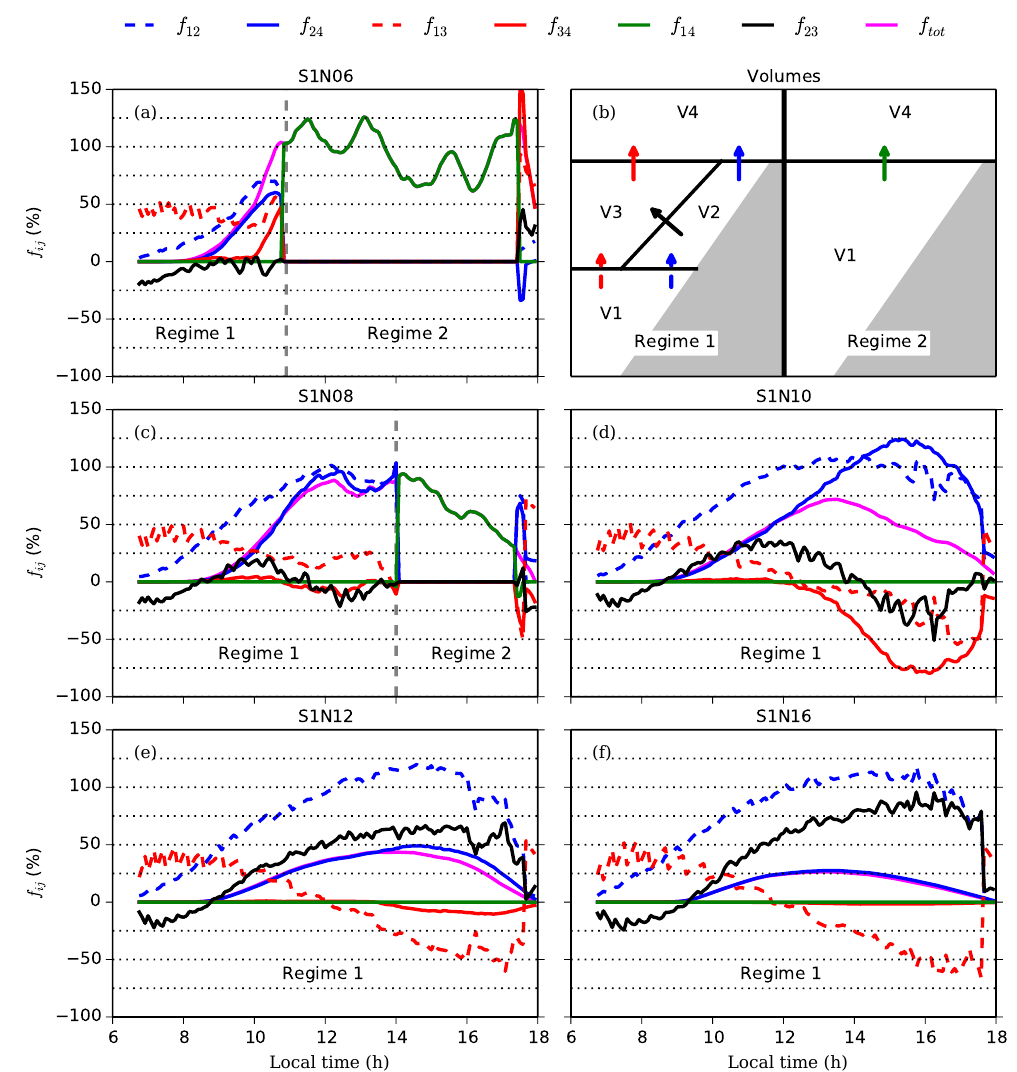
Figure 4. Normalized bulk tracer mass flux for a set of S1 simulations with five different values of initial static stability: (a) N06, (c) N08, (d) N10, (e) N12, and (f) N16. The tracer mass fluxes are integrated at the boundaries between different volumes and normalized by the spatially integrated tracer mass flux at the surface F 01 . The sketch in (b) shows the position of different volumes and associated bulk fluxes. The left side represents a valley atmosphere before the breakup (regime 1), whereas the right side shows the situation after the breakup (regime 2). A grey dashed line indicates the change from regime 1 to 2. Colours of arrows in (b) are the same as the colours of the corresponding lines in the other panels, whereby solid (dashed) arrow shafts correspond to solid (dashed)